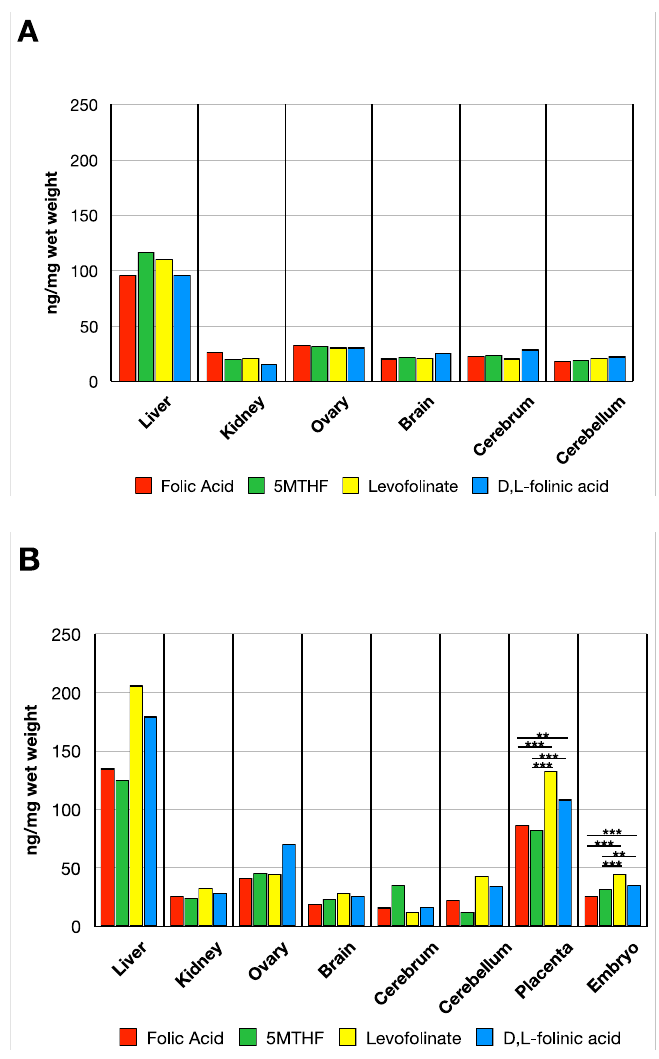
Figure 4. MTHF concentration in tissues of non-pregnant rats ( A ) and in GD 14 pregnant rats ( B ) 24 h post oral administration of various folate forms. (Sample sizes non-pregnant ( A ): Folic acid ( n = 2), 5MTHF ( n = 2), Levofolinate ( n = 2), d,l-folinic acid ( n = 2); Sample sizes pregnant ( B ): Folic acid ( n = 2), 5MTHF ( n = 2), Levofolinate ( n = 3), d,l-folinic acid ( n = 3)). Asterisks indicate the following: ** p < 0.01, *** p < 0.001.